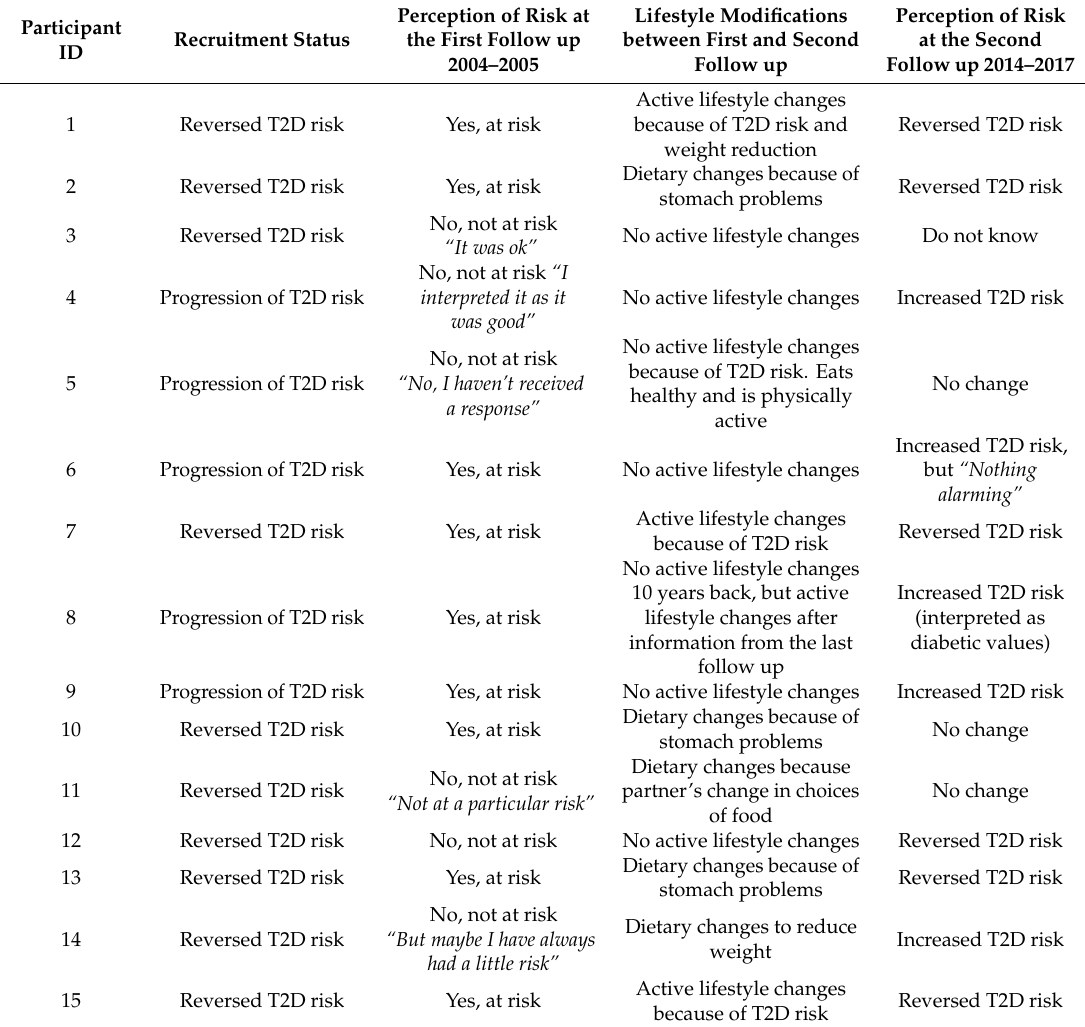
Table 3. Perceptions of risk and lifestyle modification over